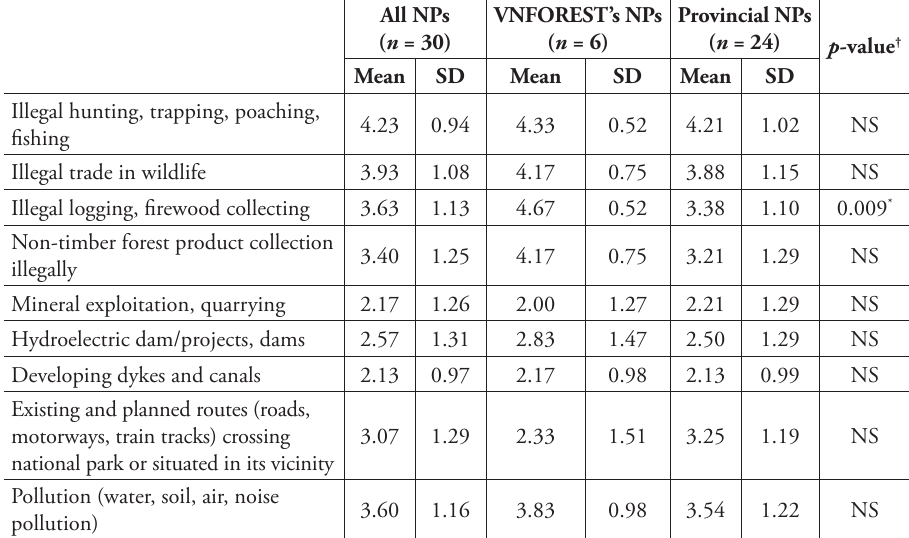
Table 11. Threats to natural resources in national parks rated from 1 (strongly disagree) to 5 (strongly agree), with a score of 3 representing